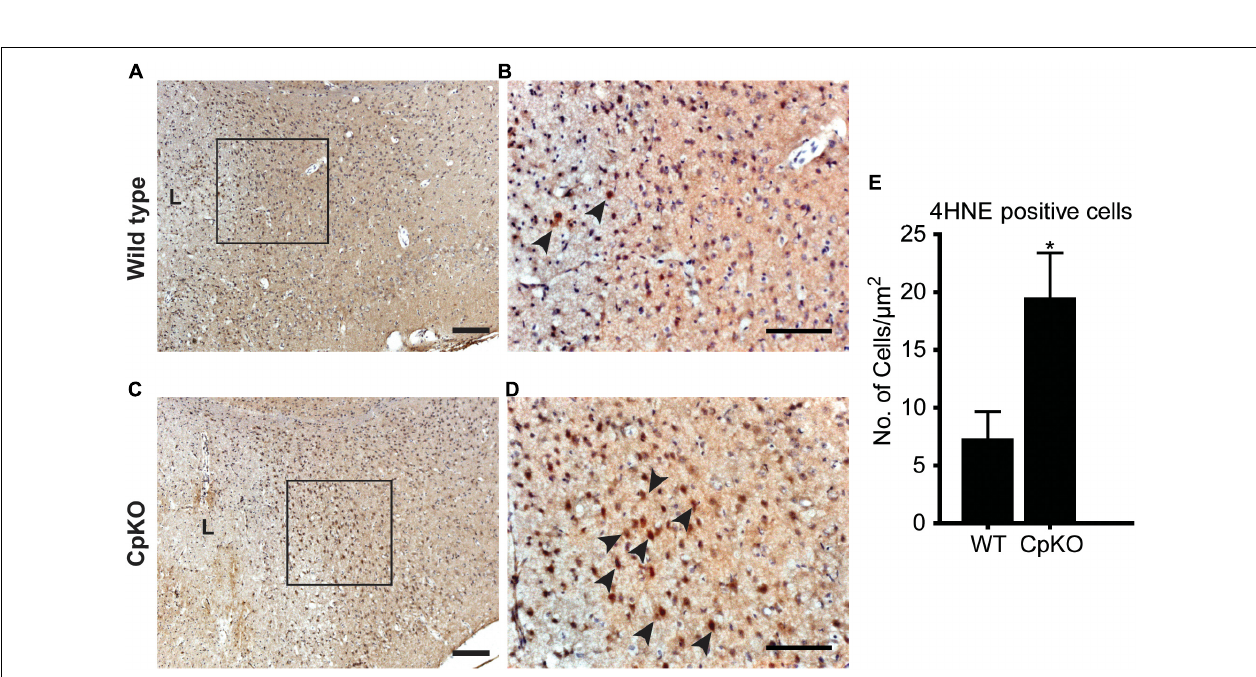
FIGURE 7 | Changes in lipid peroxidation detected by 4-HNE labeling. Tissue sections of wildtype (A,B) and CpKO (C,D) mice showing immunohistochemical staining for 4HNE. The area demarcated by the black squares in A and C are shown at higher magnification in panels B,D . The lesion area in A,C are indicated by “L.” The 4HNE staining is seen as a brown reaction product (arrowheads); the tissue sections were counterstained with Mayer’s hemalaum which labels the cell nuclei blue. (E) Graph shows that the number of 4HNE+ cells is significantly higher in CpKO as compared to wildtype mice. Scale bar = 100 µ m, ∗ p -value ≤ 0.05.